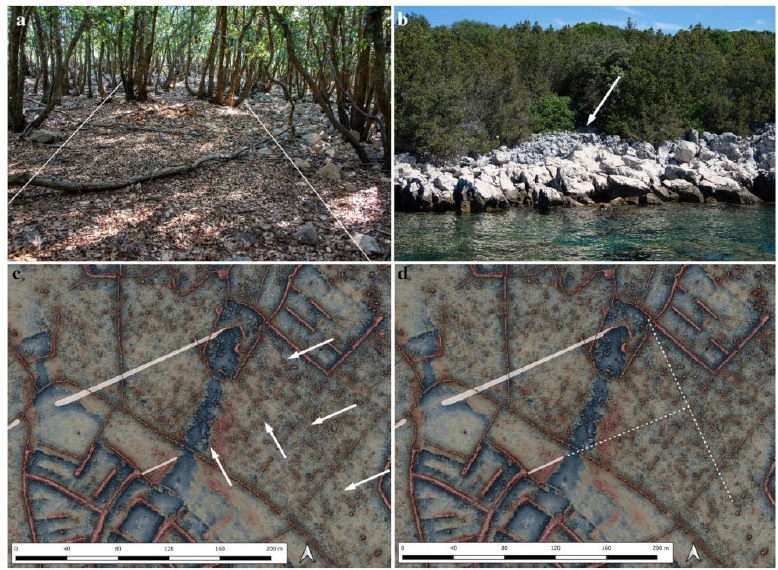
Figure 29. The long straight bank ( a ) in the inland area where it is heavily eroded and ( b ) at the shore where it comprises a bank built of stones indicated by the arrow (collapsed dry stone wall?). ( c ) What may be a regular system of field boundaries is evidenced by both well-defined banks (solid white lines) ( d ) and very ephemeral remains (pecked lines) (visualization: LRM(20) and